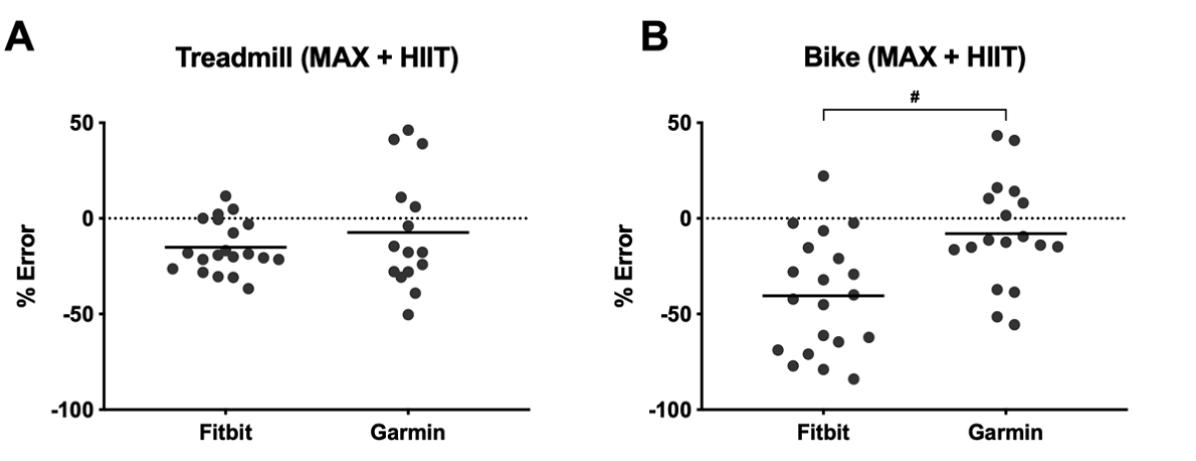
Figure 6. Percent relative error (RE) in energy expenditure (EE) during the VO 2 peak test (MAX) and high-intensity interval training (HIIT) on the treadmill (A) and cycle ergometer (B) for Fitbit and Garmin. Negative bias in estimating EE is demonstrated by both devices during both modes of exercise, with the greatest mean error displayed by Fitbit during MAX and HIIT performed on the cycle ergometer. The horizontal lines represent the mean. # indicates P <.001.